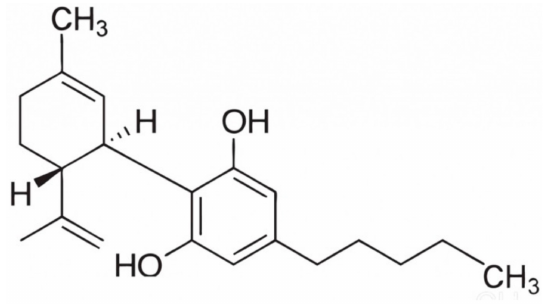
Figure 1. Cannabidiol chemical